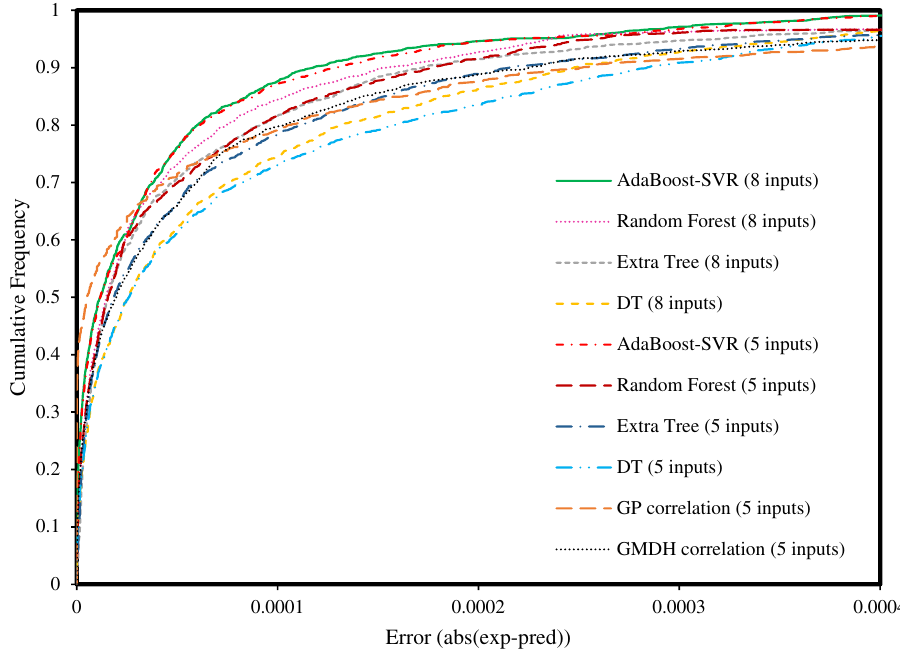
Figure 6. Cumulative frequency plot of the proposed predictive tools for estimating the solubility of hydrocarbon gases.